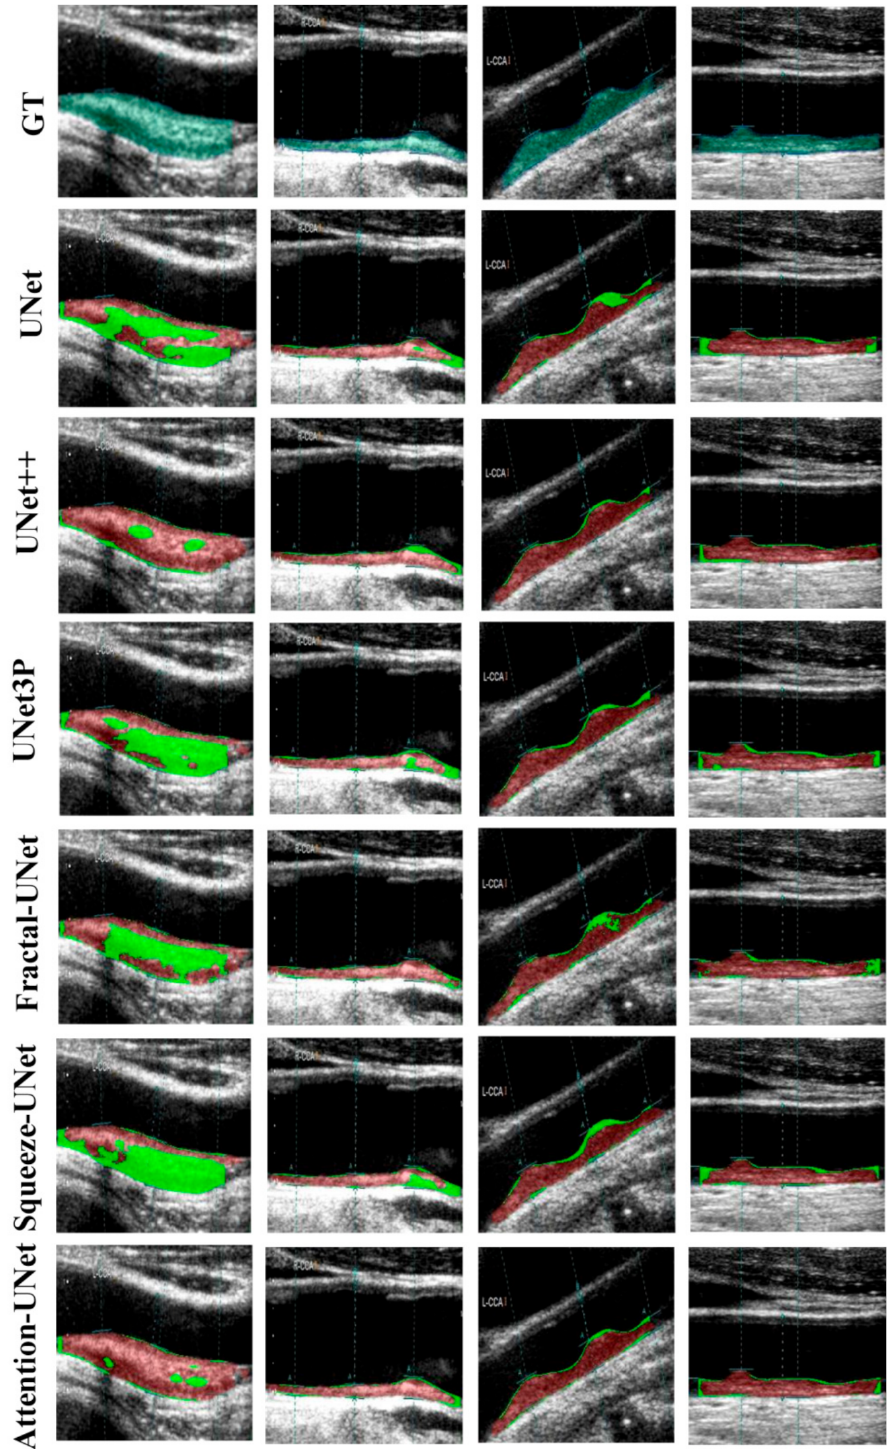
Figure 9. Attention channel effect on plaque segmentation on critical images of moderate and high